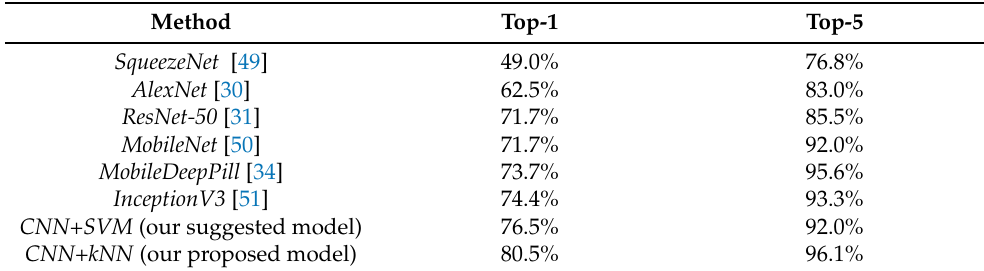
Table 3. Top-k Accuracy in Related Models (%).